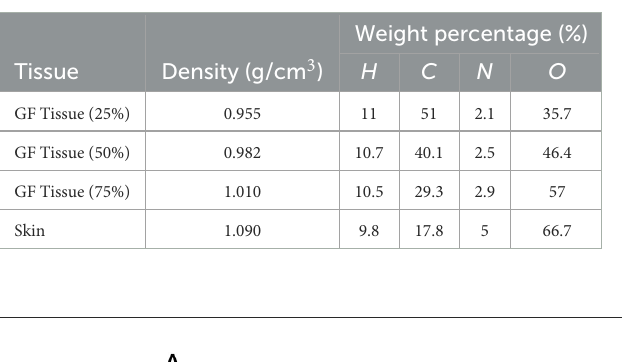
TABLE 1 Elemental properties and densities of the modeled breast layers (11).